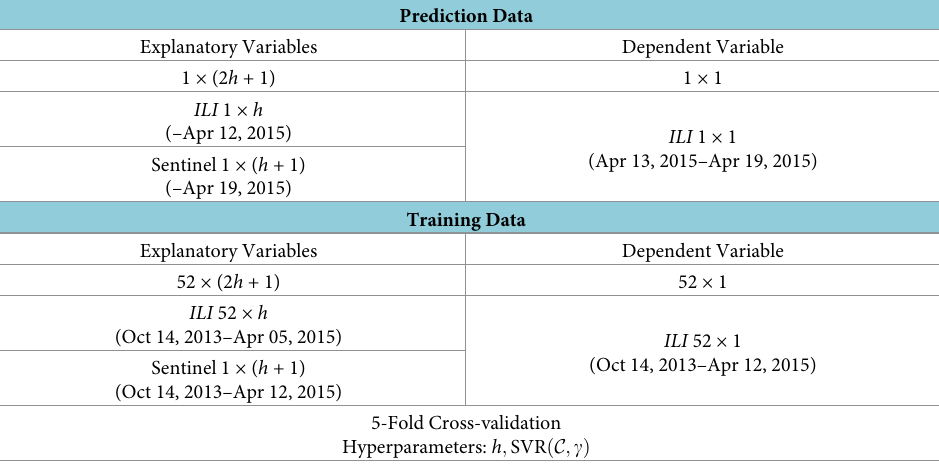
Table 3. Example settings of forecast models. An example settings for 1-week-ahead prediction at forecasting week 2015 − 15 with only one sentinel involved, where h is the window